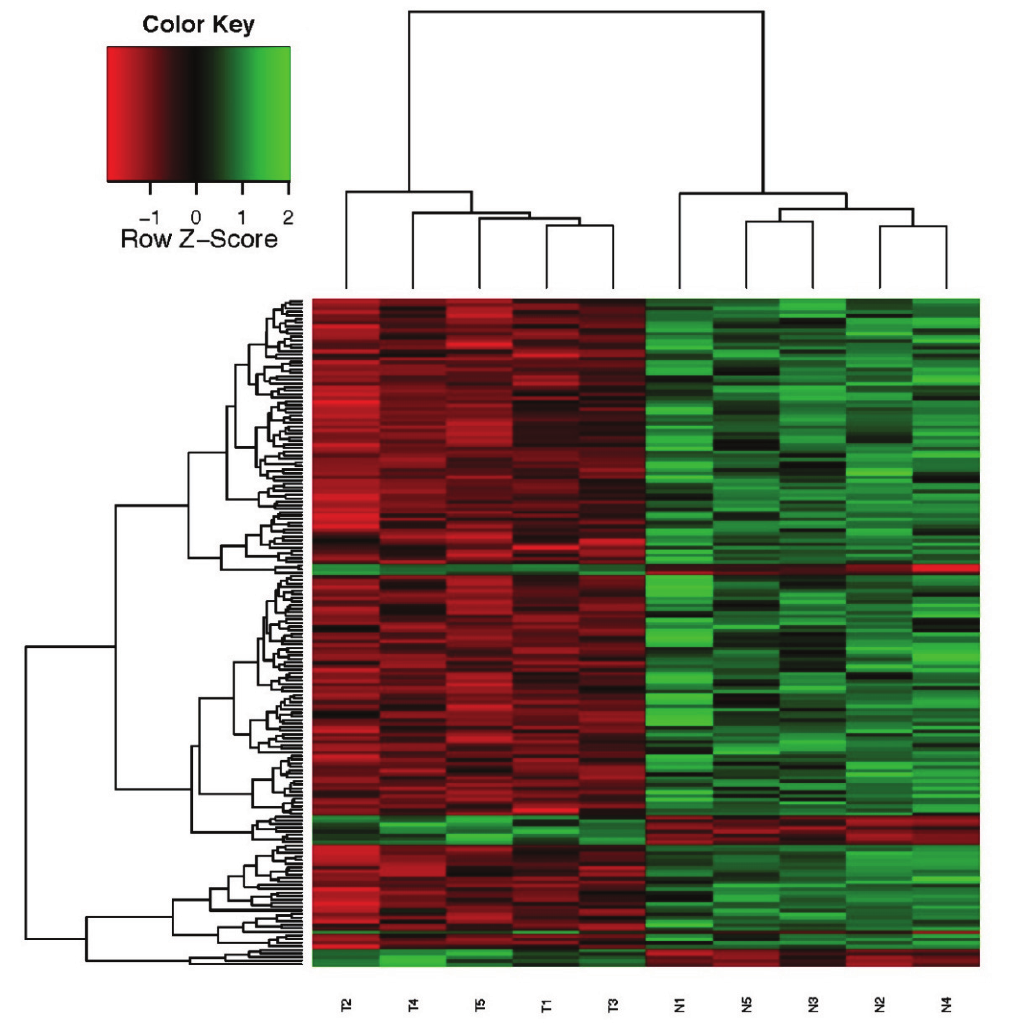
Figure 1. Heat map of cDNA microarray expression data from breast cancer patients with overexpressed IGFBP5 in tumor tissue compared to adjacent normal